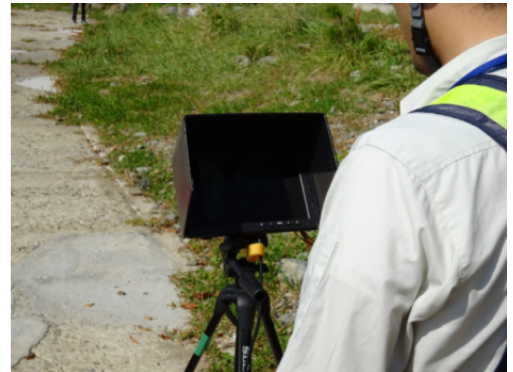
Figure 3. Steering the drone by iPad.